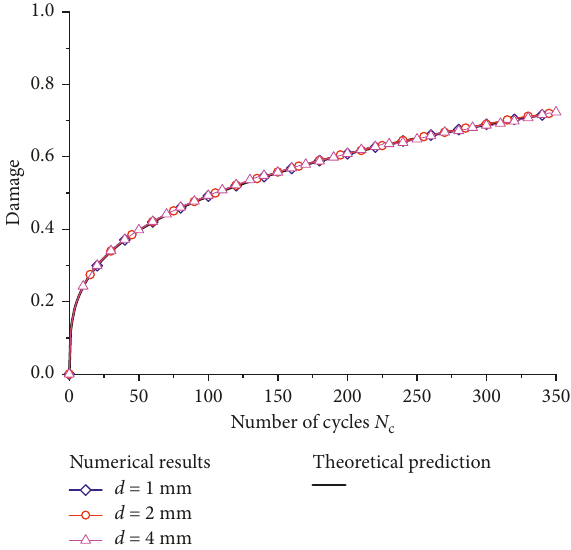
Figure 7: The theoretical and numerical predictions of the increase of damage for an uncracked plate subjected to fatigue